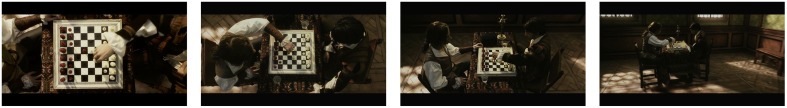
The four screenshots represent the timeline of the long-running chess sequence; the first frame also illustrates the single event contained within the 1-s stimulus version.